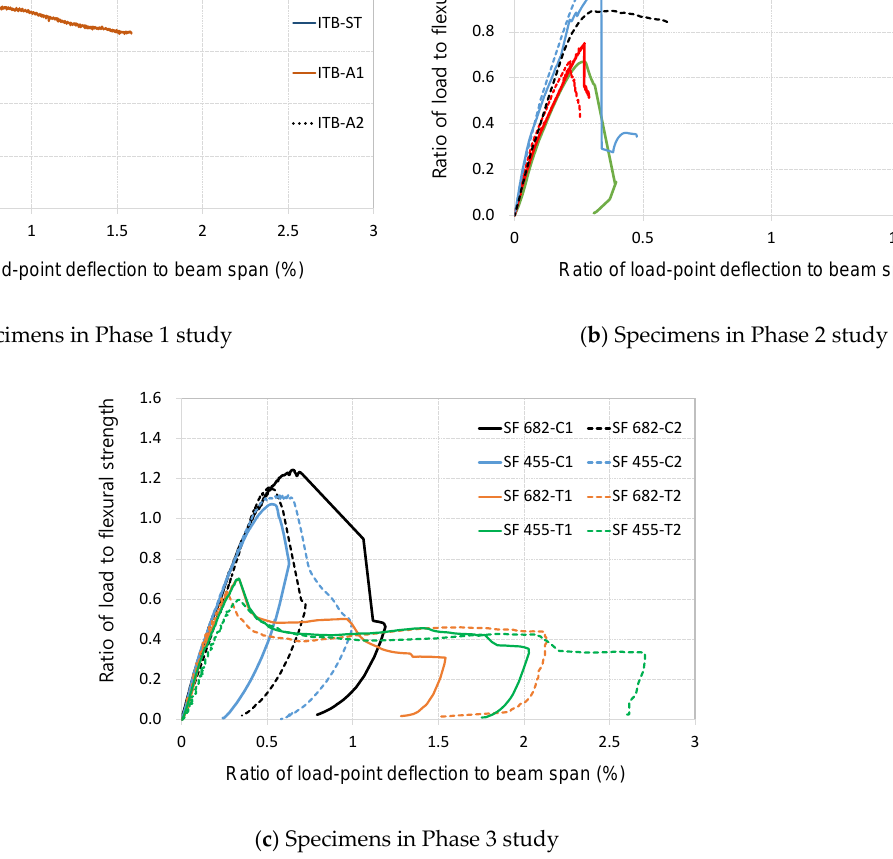
Figure 5. Normalized load versus deflection relationships.